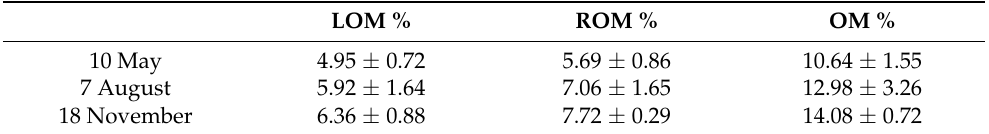
Table 3. Percentages (mean among nine values ± SD) of labile organic matter (LOM), refractory organic matter (ROM), and total organic matter (OM) compared to the sediment brought to constant weight at 75 ◦ C from samples collected at Burano between May and November 2021, along a central transect arranged along the length of the basin. LOM % ROM % OM % 10 May 4.95 ±